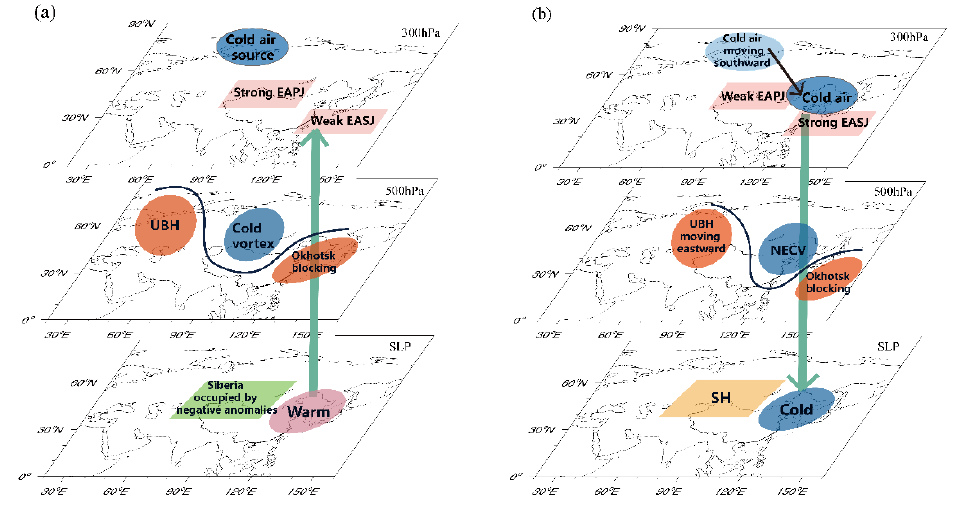
Figure 11. Schematic diagram of the configuration of the circulation systems in the ( a ) early stage and ( b ) later stage of LECEs.